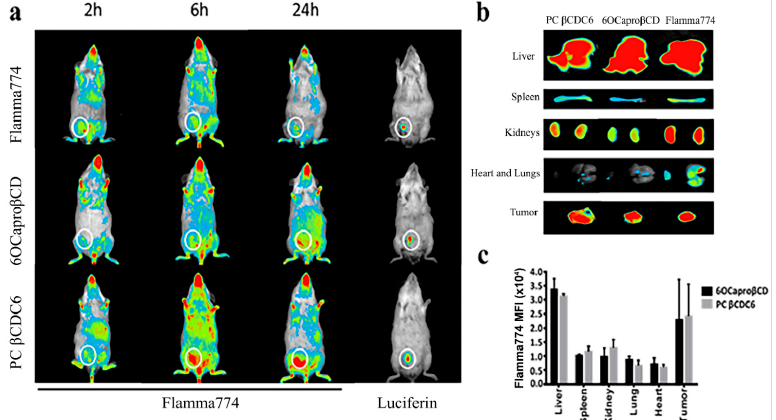
Figure 10. Biodistribution of amphiphilic cyclodextrin nanoparticles and dye solution in breast tumor-bearing mice for 24 h ( a ), accumulation of nanoparticles and dye solution in organs in mice that were sacrificed at the end of 24 h ( b ), and mean fluorescence intensity of Flamma ® 774 in organs (mean ±SD) ( c ). Tumor developing in mice highlighted in a white ring.